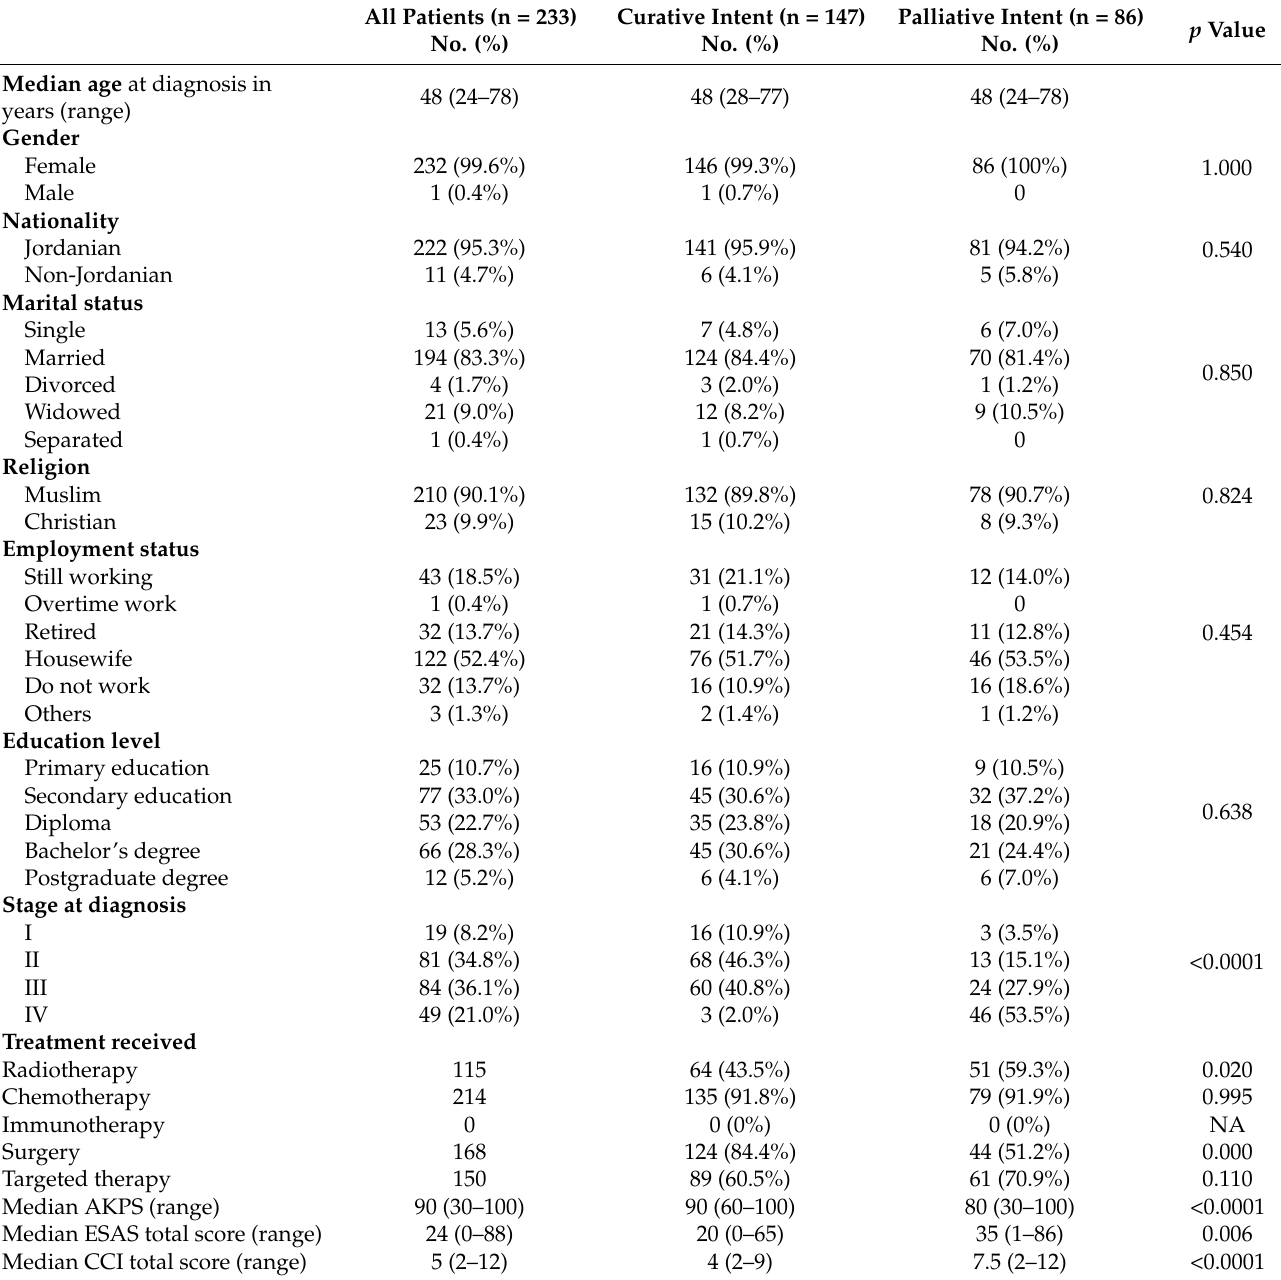
Table 1. Demographic and clinical characteristics of patients with breast cancer (n =